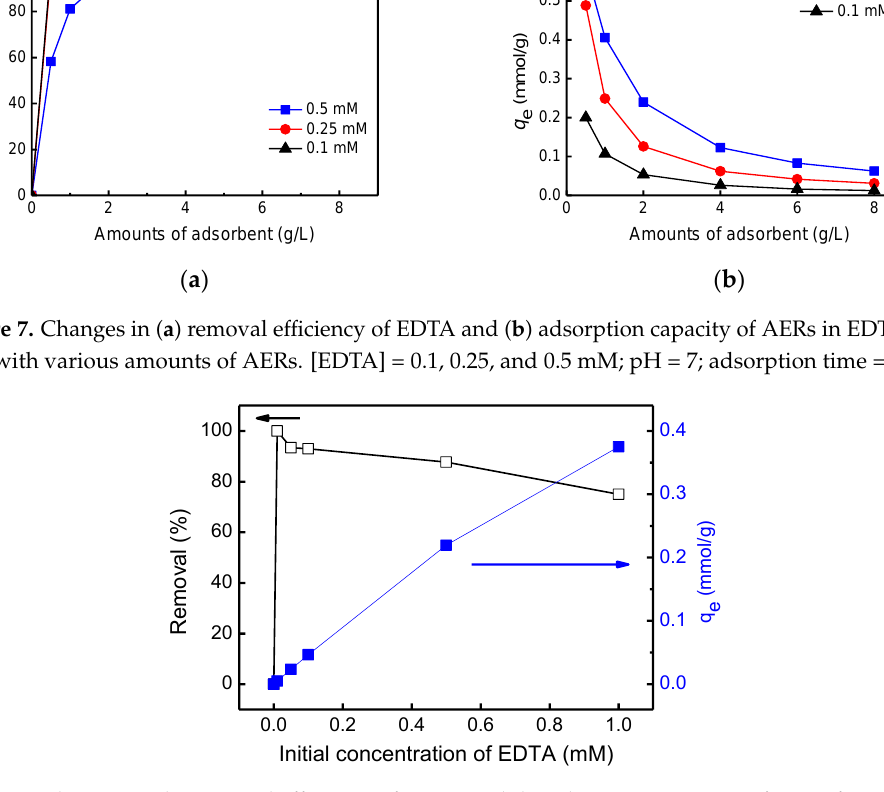
Figure 8. Changes in the removal efficiency of EDTA and the adsorption capacity of AERs from 1 mM EDTA/Cs (1:1) solutions containing various EDTA concentrations. [AERs] = 2 g/L; pH = 7; adsorption time = 5 h.